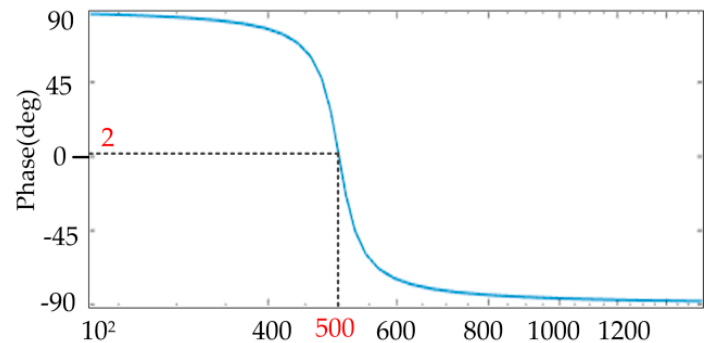
Figure 4. Phase-frequency characteristic curve of bandpass filter (BPF).